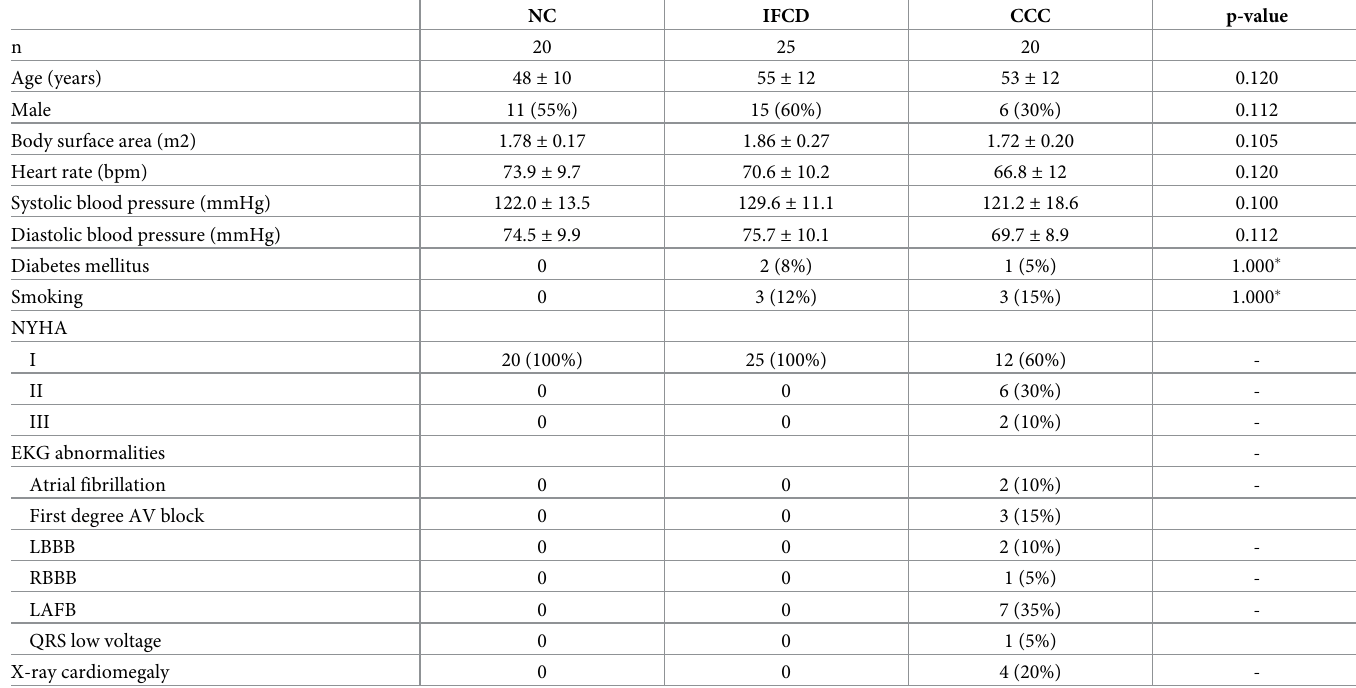
Table 1. Demographic and clinical characteristics across the